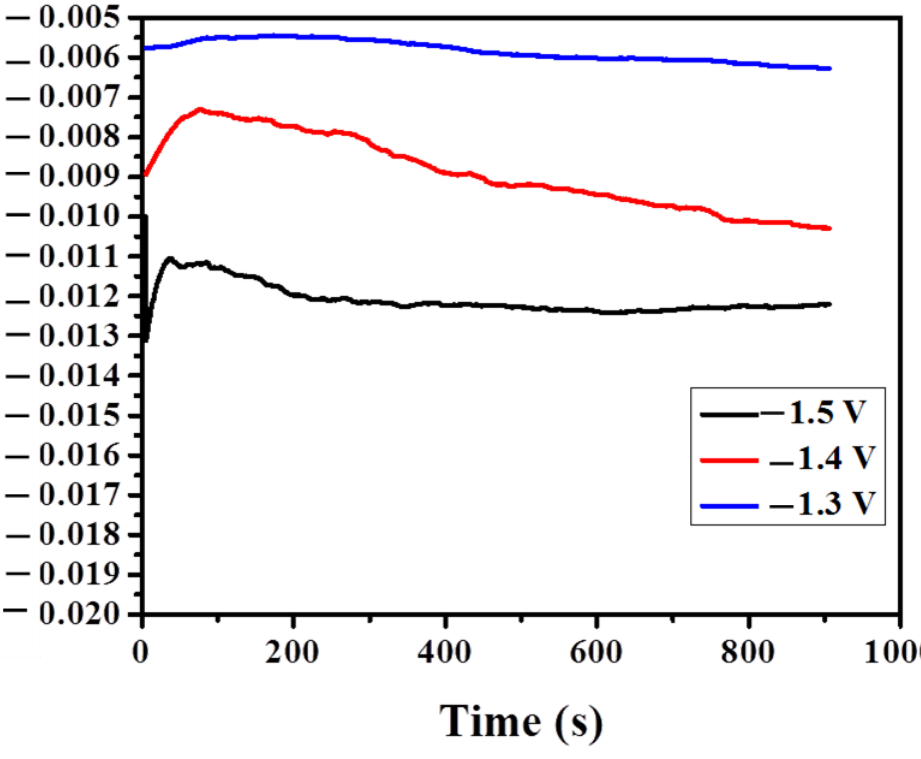
Figure 1. In situ deposition of Co-Cu-Fe-Zn oxides simultaneously on FTO at different values of deposition potential using 1 M KOH as a supporting electrolyte for 900 s.